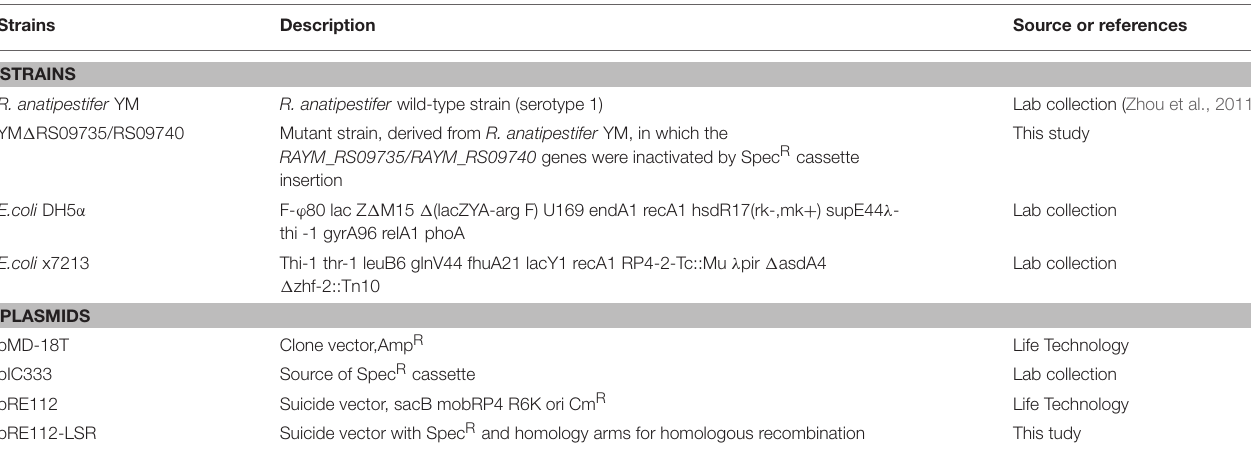
Table 2 . In vivo -induced antigen technology (IVIAT)